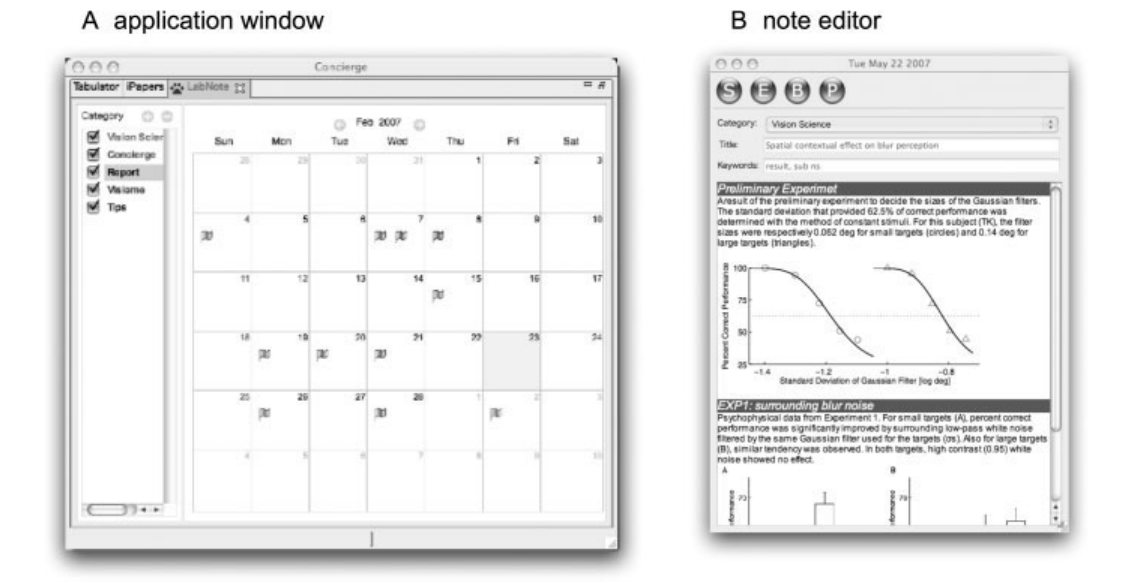
Figure 6. Screenshots of the LabNote plug-in . The application window ( A ) comprises a category browser and a calendar. By clicking a date on the calendar, users can summarize research activities with related resources on the dialog window ( B